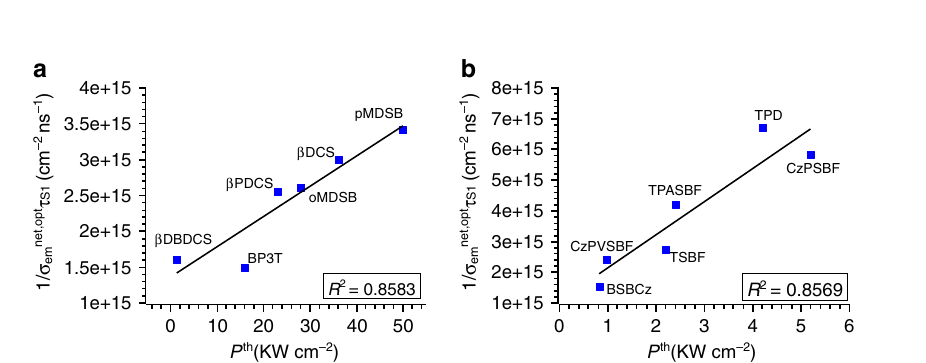
(cid:2) (cid:3) λ (cid:3) . a Linear relationship between P th and ´ τ S 1 em em